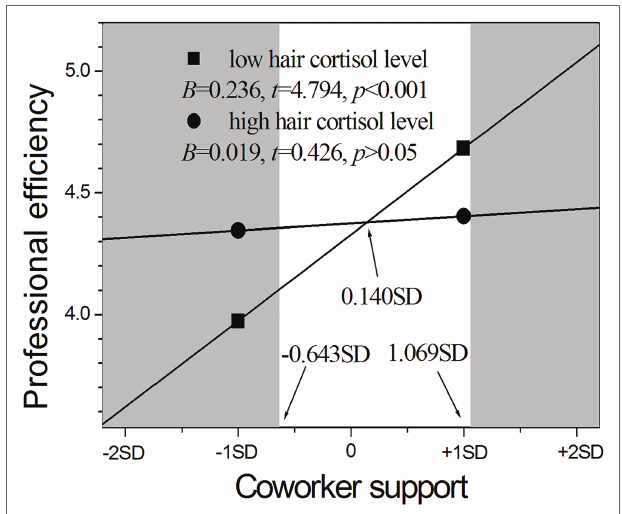
FIGURE 3 | The moderating role of hair cortisol in the relationship between coworker support and professional